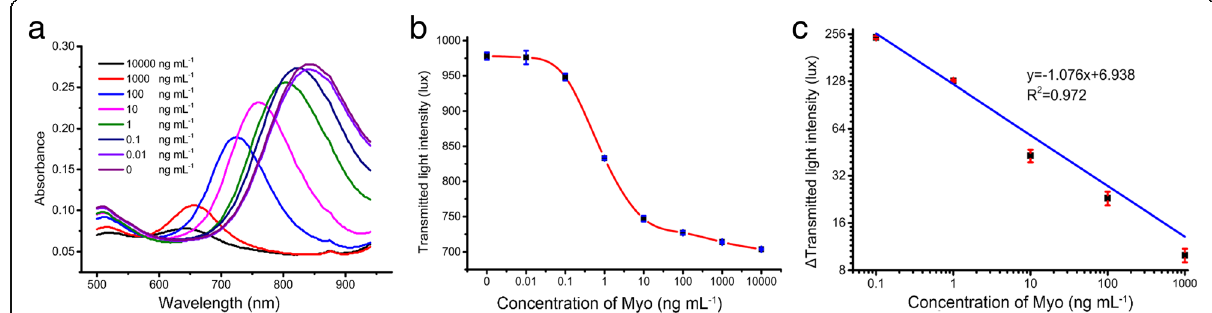
Fig. 4 Plasmonic immunoassay for Myo detection. a LSPR peak shifts of AuNRs at different concentrations of Myo. b Absorbance of AuNRs for the detection of different concentrations of Myo. c Calibration line of plasmonic immunoassay for Myo detection as read by smart phone-based reader. Each value presents the mean from three replicates